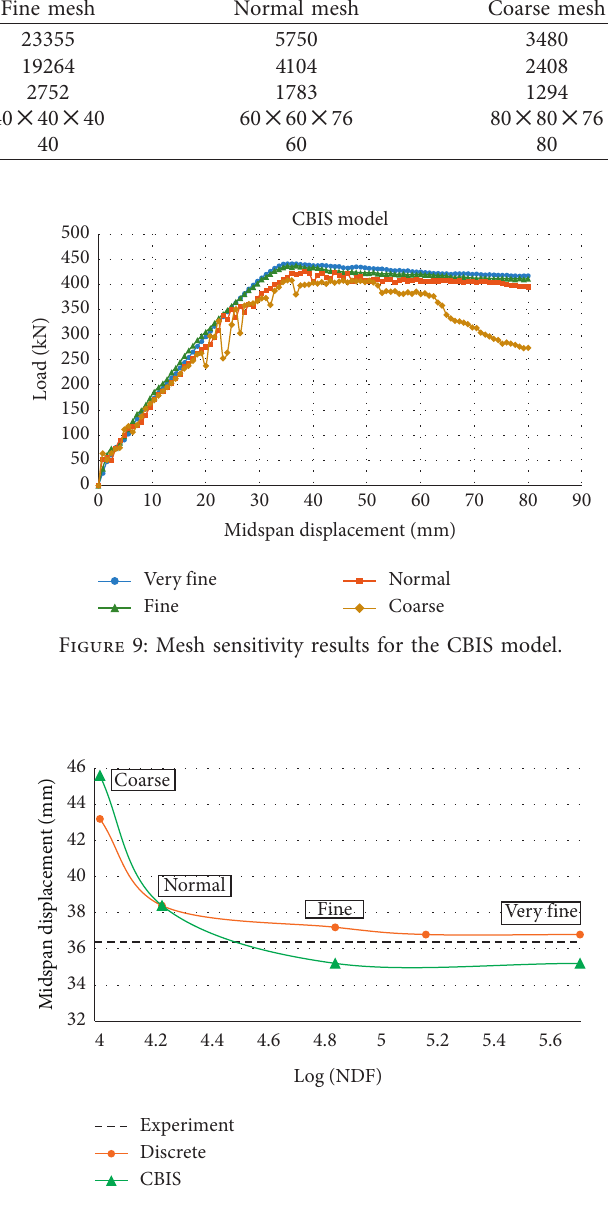
Figure 10: Convergence characteristics of midspan displacement with respect to the increase in